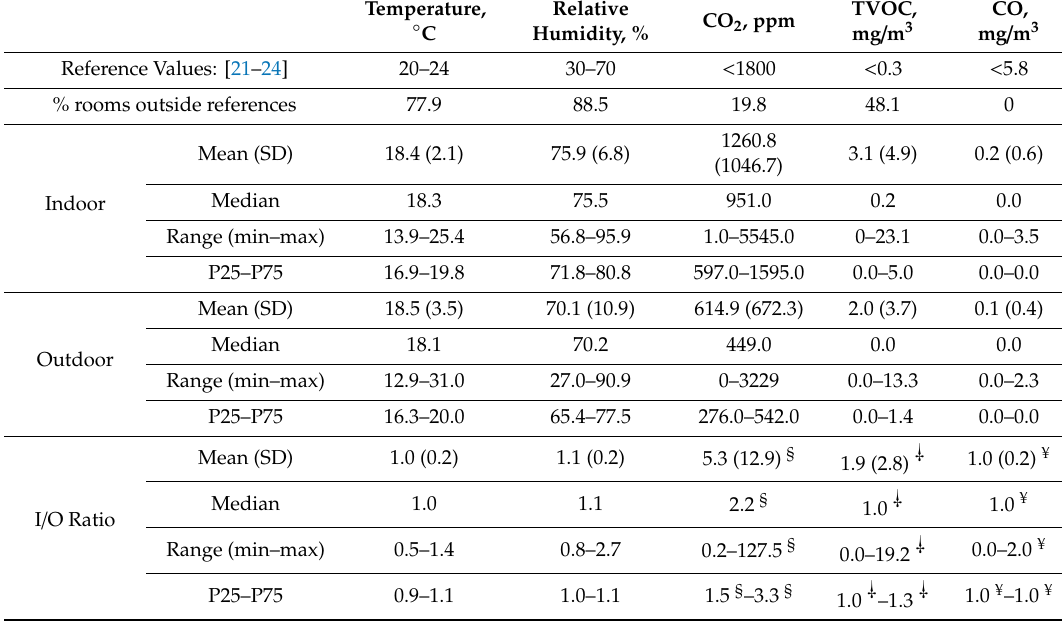
Table 3. Indoor air quality parameters, outdoor air quality parameters, and indoor/outdoor (I/O) ratios. (Legend: n = 131, except for § where n = 128 valid cases; ⸸ where n = 109 valid cases; ¥ where n = 121 valid cases).